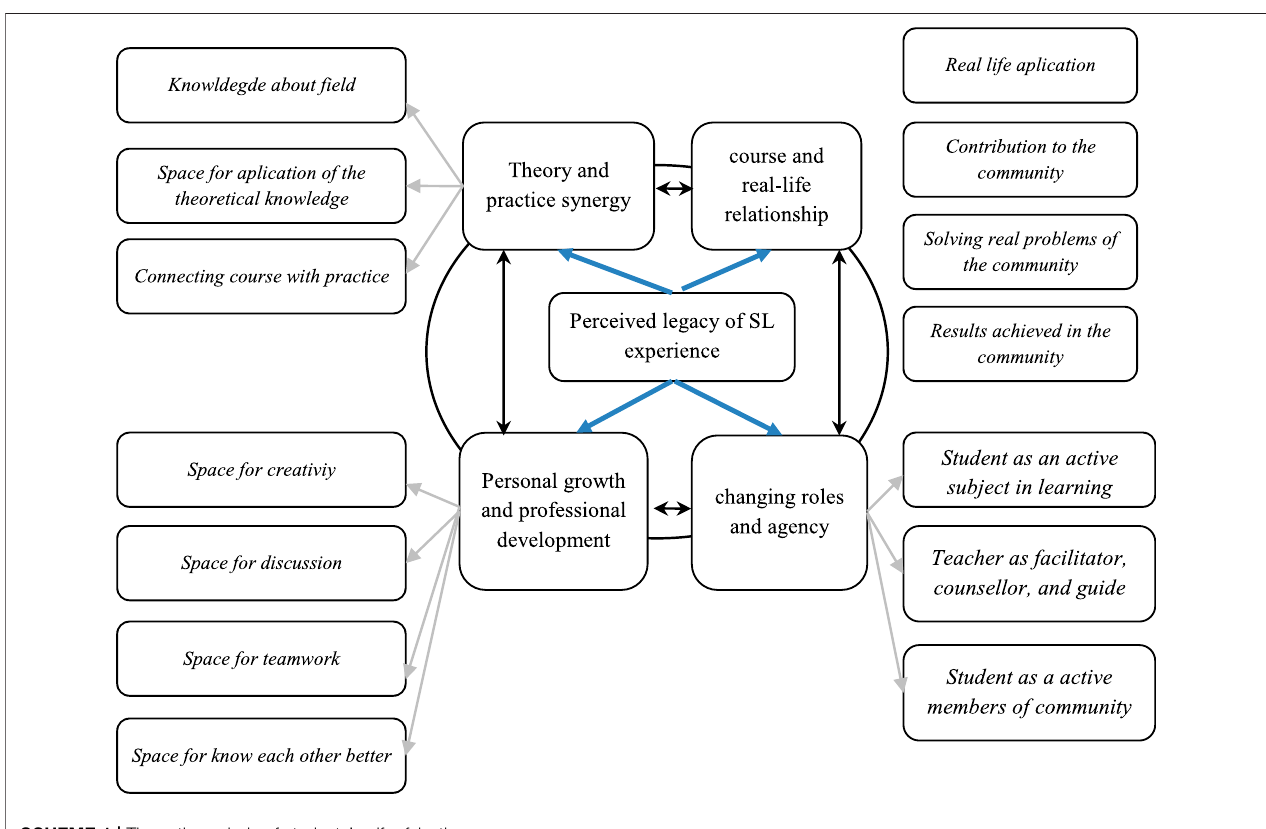
SCHEME 1 | Thematic analysis of students ’